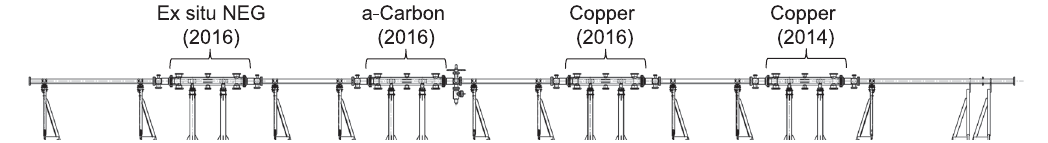
FIG. 3. Layout of the field free and room temperature VPS system, installed in the LHC ring. It is composed of four stations for the measurement of EC of different surfaces and coatings. Since 2016, ex situ NEG, a-C and copper have been installed and studied.